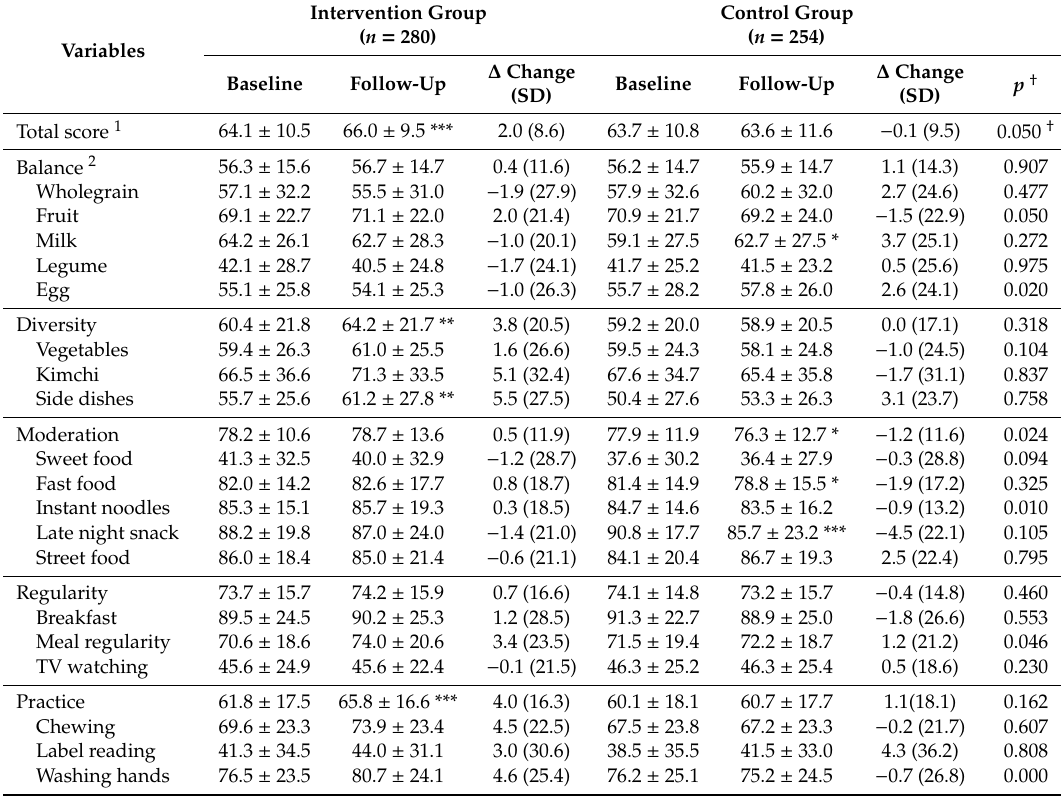
Table 3. Changes in 19 items of the NQ of the children after participating in the Mission-X program according to their group.